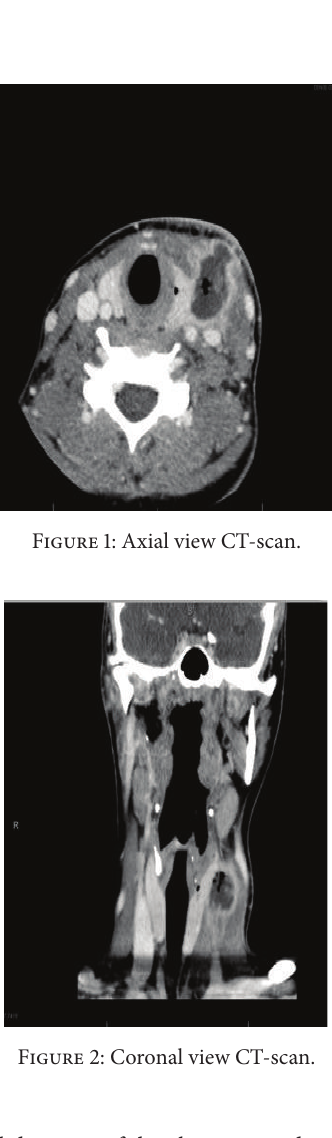
(Figure 8: fistula’s tracts between the left thyroid nodule